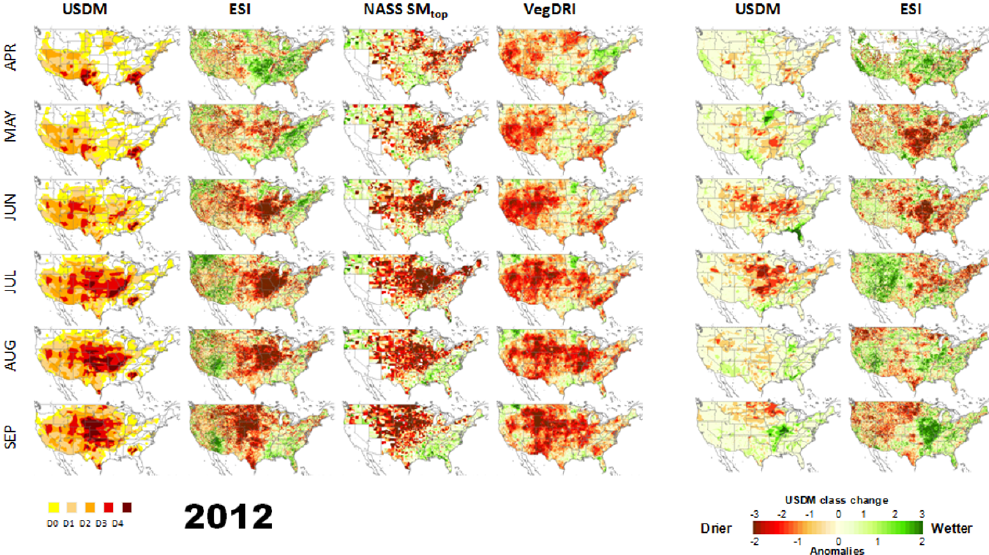
Figure 2. Comparison of drought evolution between the U.S. Drought Monitor classification, the Evaporative Stress Index (ESI), and the Vegetation Drought Response Index (VegDRI). The figure is adapted from Anderson et al. (2013b) and distributed under a CC BY-NC-ND- 3.0